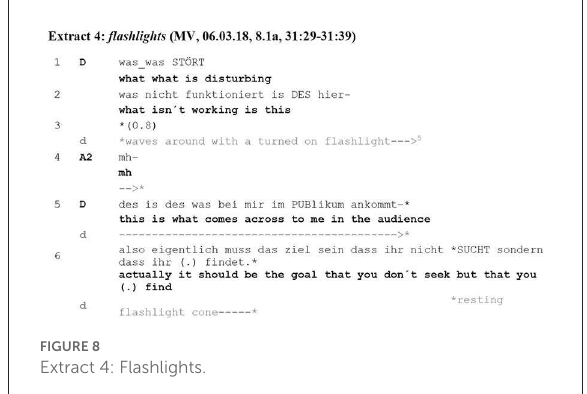
FIGURE8 Extract 4: